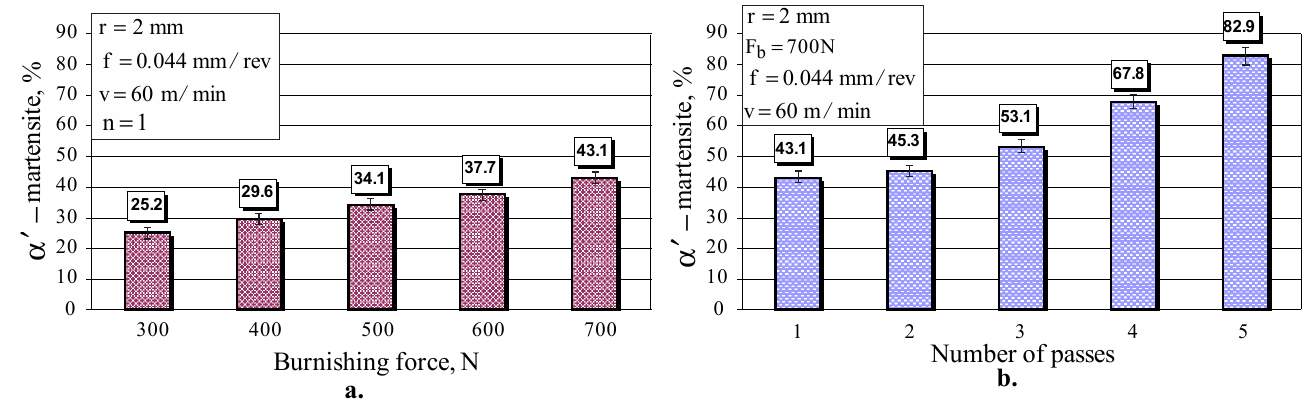
Figure 12. Effect of: ( a ) burnishing force, and ( b ) number of passes, on strain-induced martensite in the surface layer.